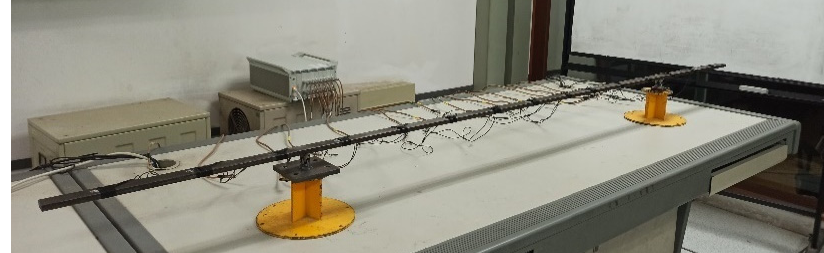
Figure 9. Laboratory test setup.